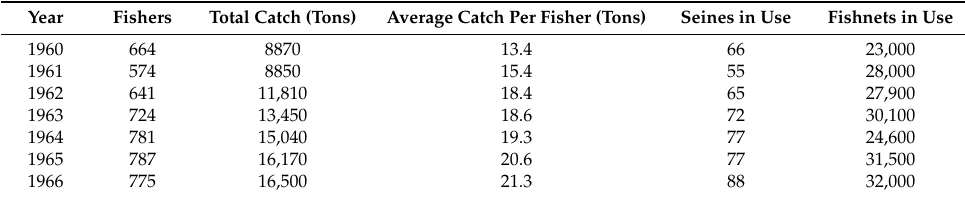
Table 3. Commercial catches and fishing operations on Balkhash Lake (1960–1966) (Source: Kazakh Research Institute of Fishery).